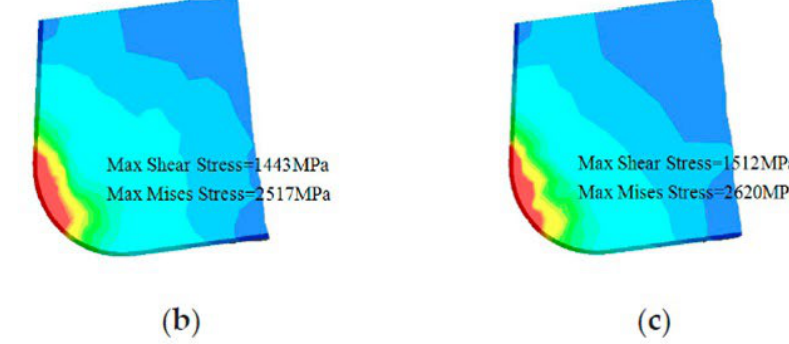
Figure 13. Comparison of max shear stress and Mises stress: ( a ) d = 80 µ m micro-hole tool; ( b ) d = 120 µ m micro-hole tool; ( c ) non-textured tool [78] .